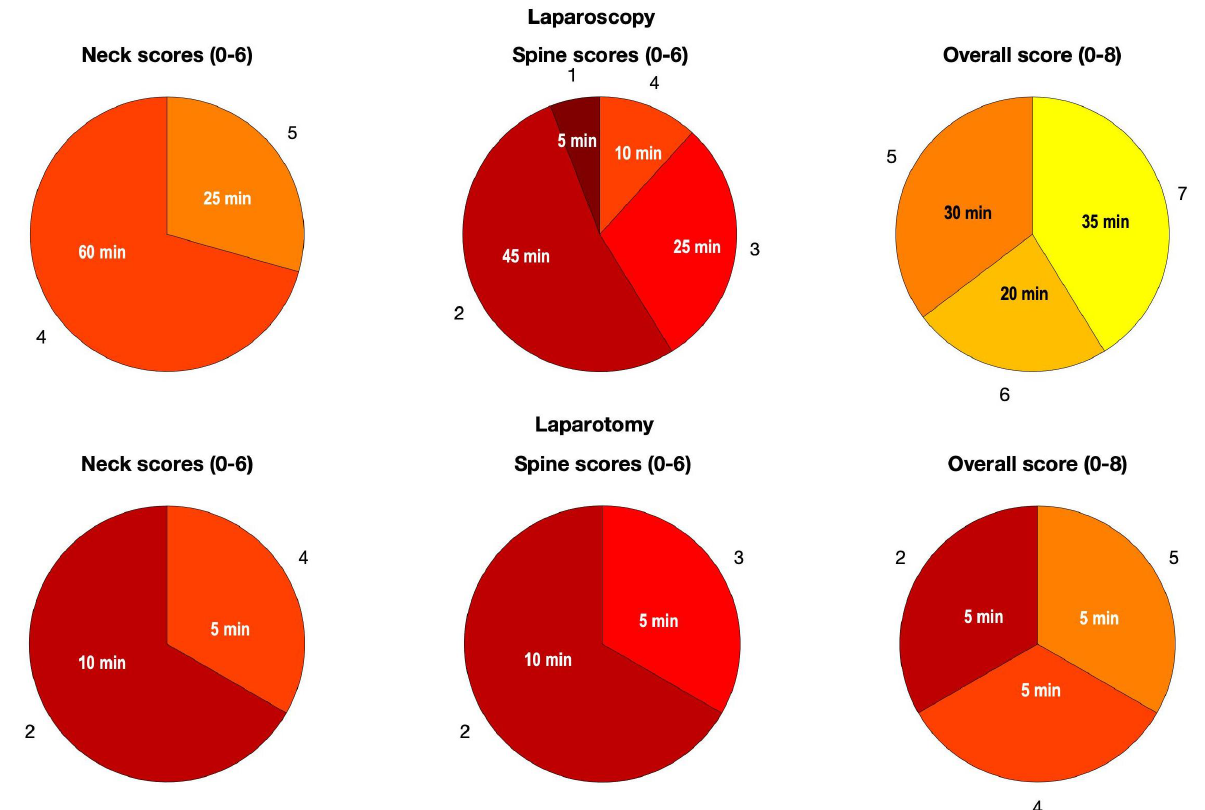
Figure 10. Pie charts describing the temporal percentages of the scores during the two